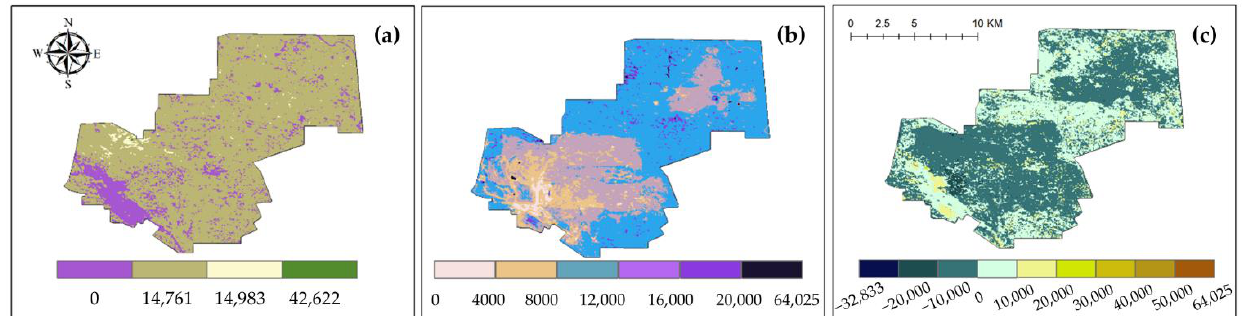
Figure 7. ESV value curve from 1986 to 2021.